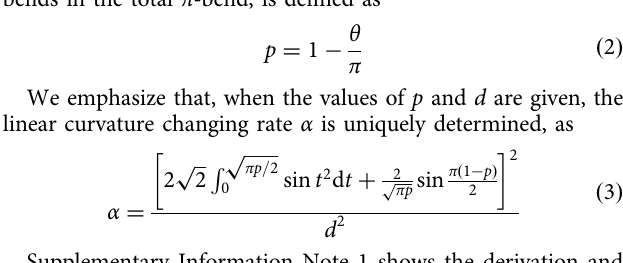
Supplementary Information Note 1 shows the derivation and numerical plot of α as a function of d and p . Particularly, the numerical plot of α as a function of p with a constant d shows that, the value of α decreases monotonously with p , and its minimum value is reached when p = 1. This may suggest that